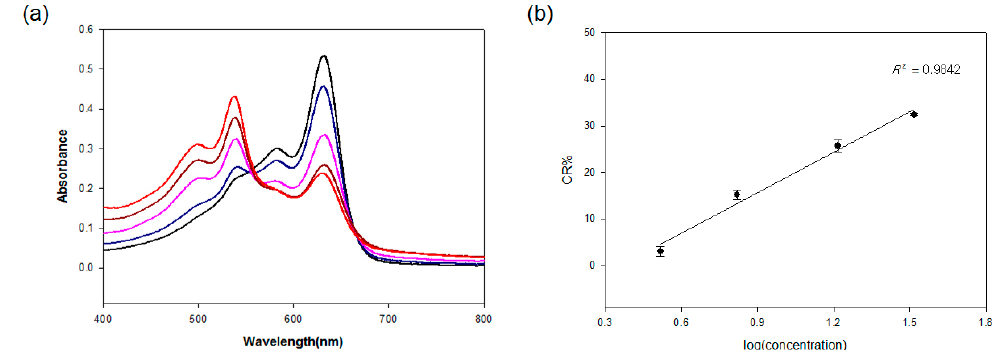
Figure 2. ( a ) Visible spectroscopy for different antigen concentrations (0 ( black ), 3.3 ( blue ), 6.6 ( pink ), 16.5 ( brown ), 33 μ g/mL ( red )); ( b ) Correlation curve between the CR% and log (concentration of the virus antigen). All experiments were performed in triplicate.